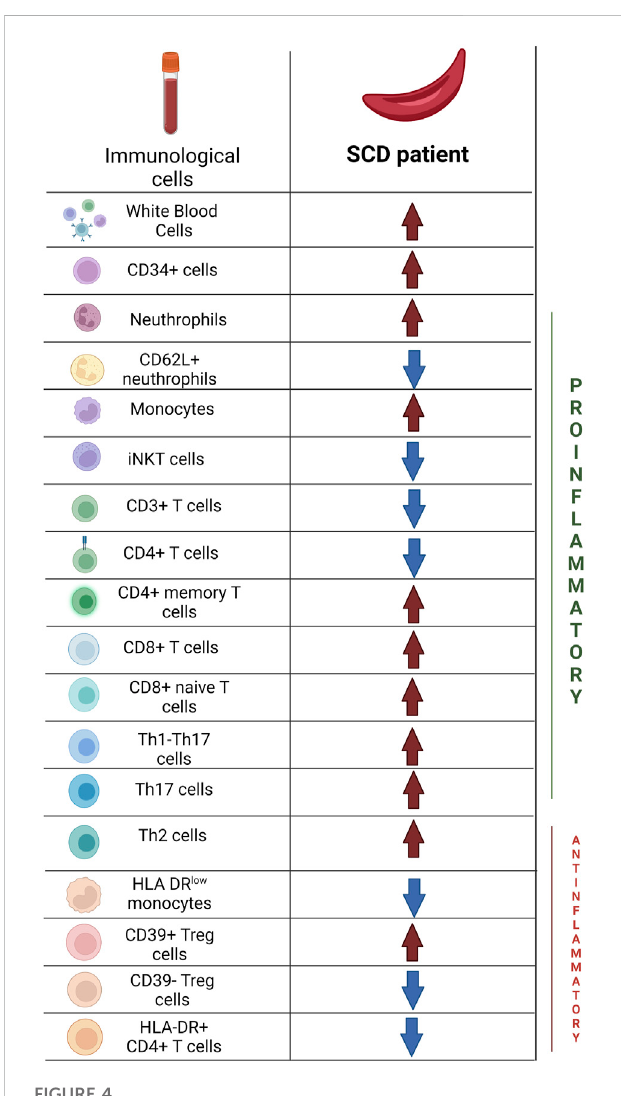
FIGURE 4 Main differences in immunological pro fi le between Sickle Cell Disease patients and Healthy Donors. Created with